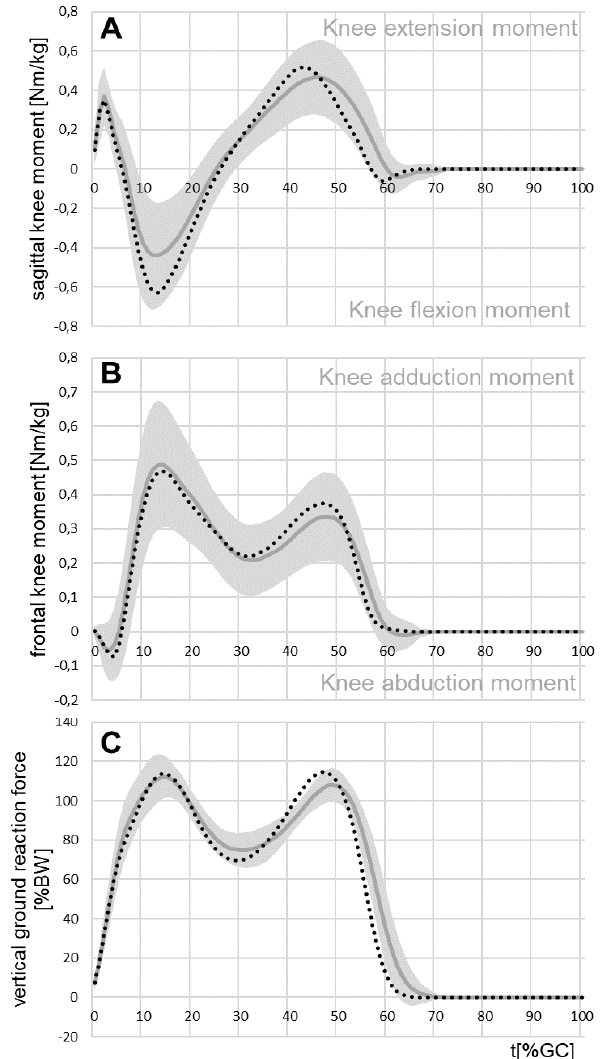
Figure 3: Selected mean parameters for the sound side of the TTs with standard deviation (grey) and for the control group (dotted, black). A: external sagittal moment acting on the knee joint, B: external frontal moment acting on the knee joint, C: vertical ground reaction